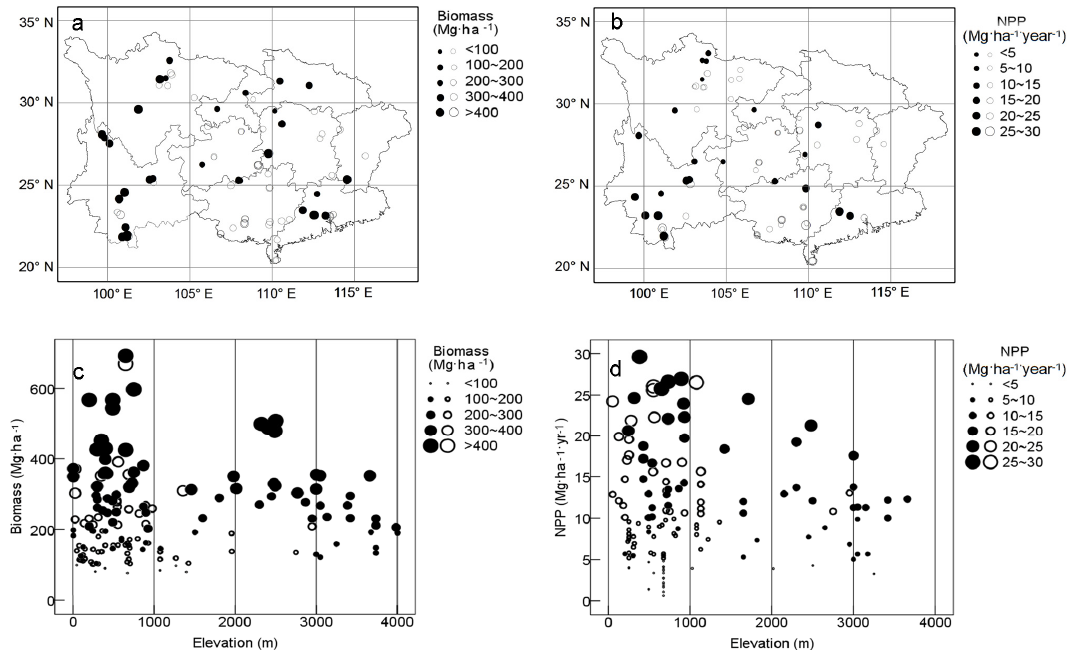
Figure 2. Distribution patterns of mature forest biomass and all forest NPP classes in relation to latitude, longitude ( a , b ), and elevation ( c , d ). Dots: biomass/NPP of natural forests; cycles: biomass/NPP of planted forests.